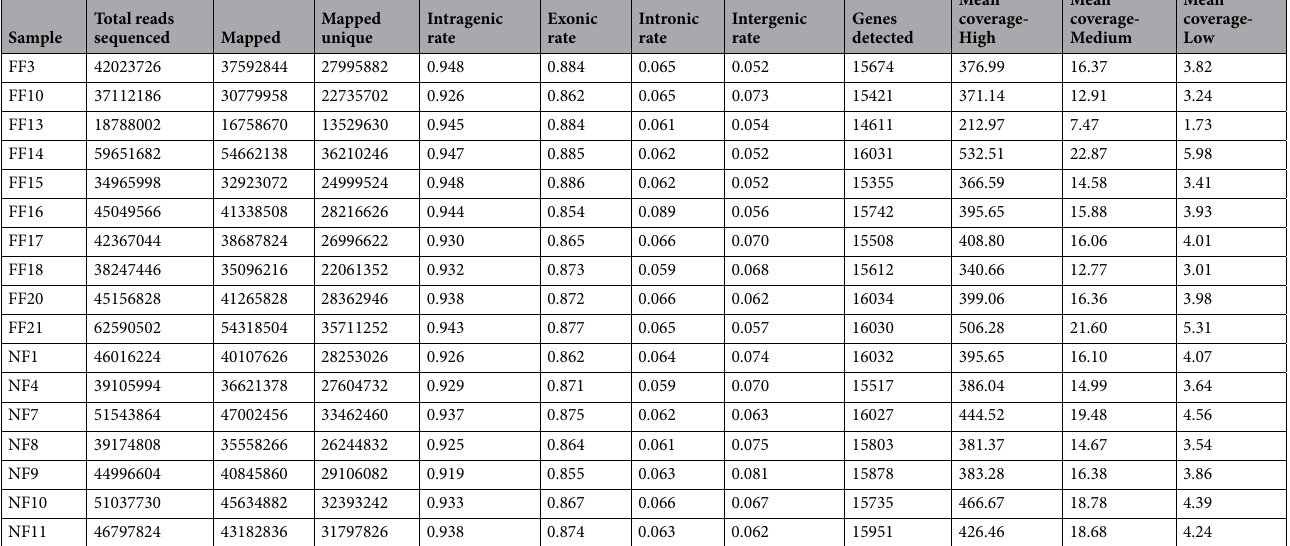
Table 2. The total reads sequenced, the intragenic/exonic/intronic/intergenic rates, and the number of genes detected in each sample are presented here. High, medium, and low mean coverage calculations are based on the top 1000, middle 1000, and bottom 1000 expressed transcripts,